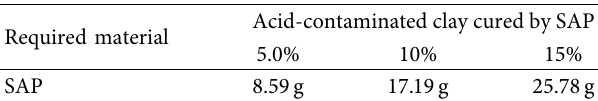
Table 6: Mass of SAP required for preparing acid-contaminated clay cured by SAP of different